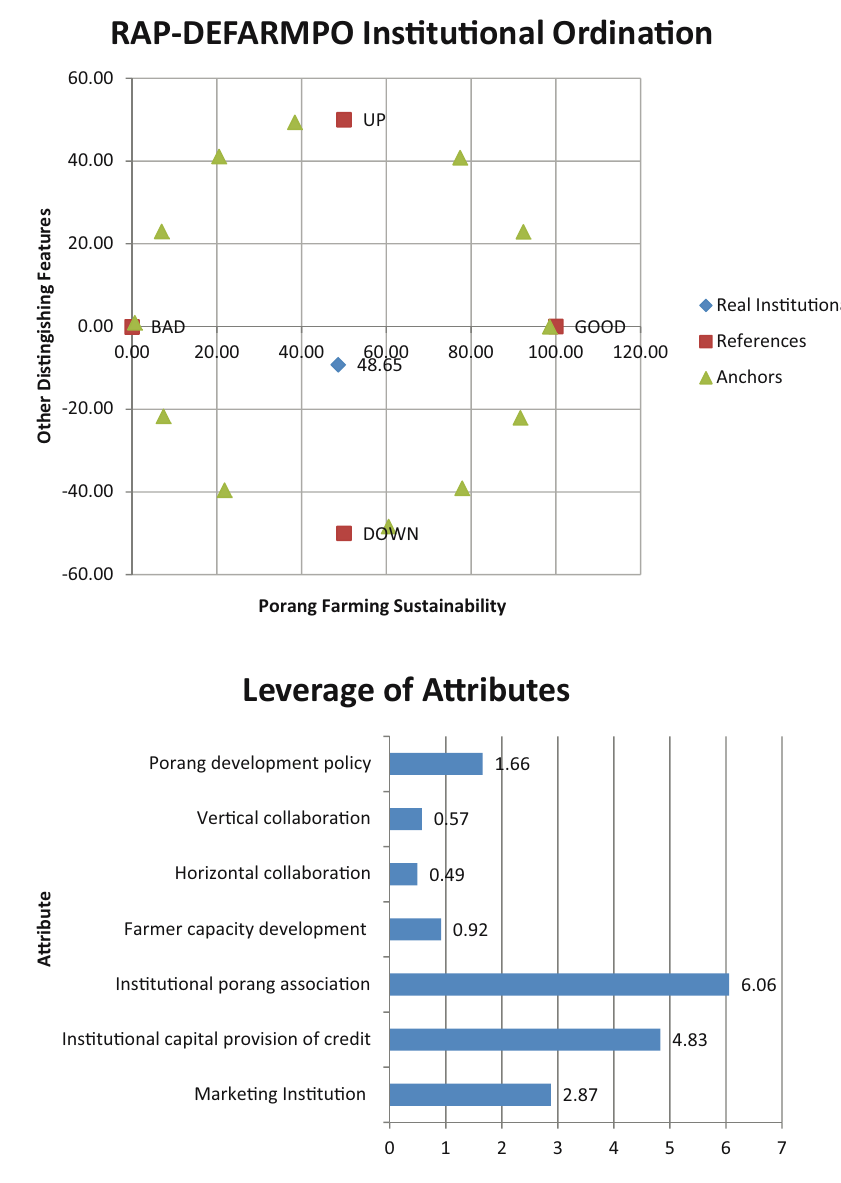
Figure 6: Institutional